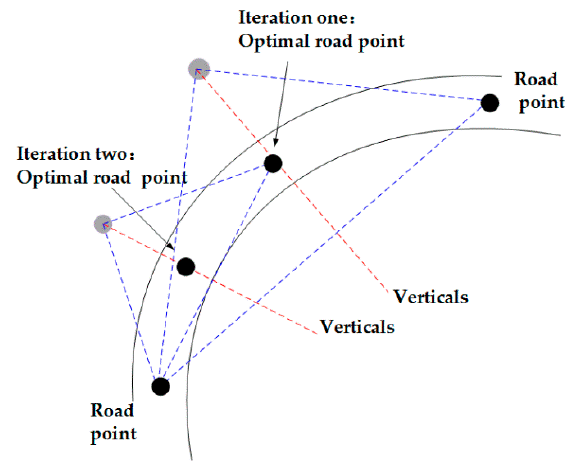
Figure 6. Road line connection.